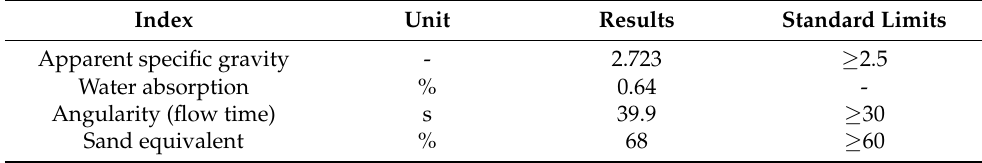
Table 3. Basic physical parameters of fine aggregate.